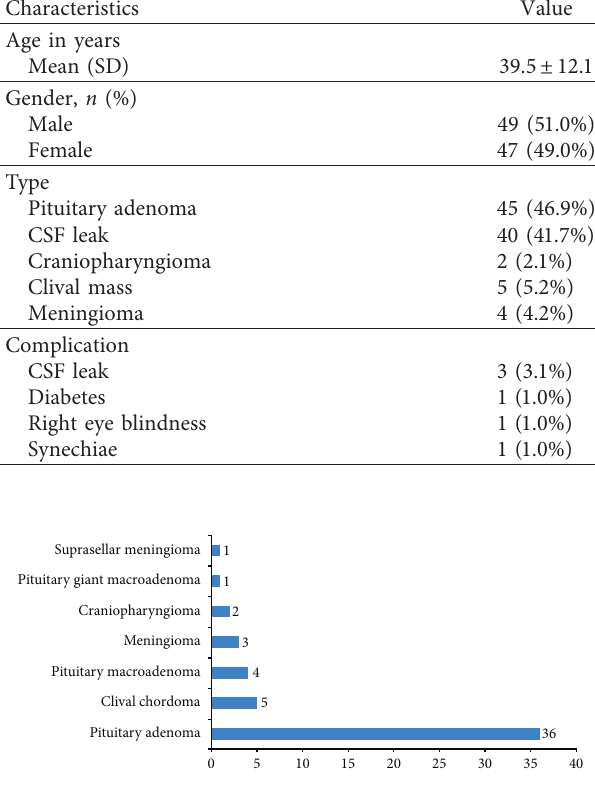
Table 1: Demographic characteristics ( n � 96).